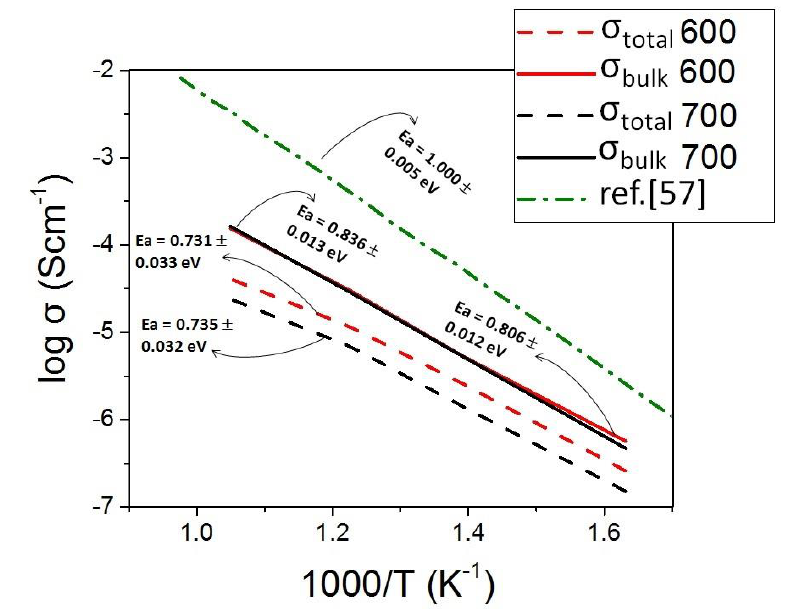
Figure 6. Arrhenius plot comparing the behavior of dense polycrystalline CGO [57] with the bulk response (high frequency region, conduction along the nanofibers) and with the total electrochemical response (along the nanofibers and across the nanofibers).